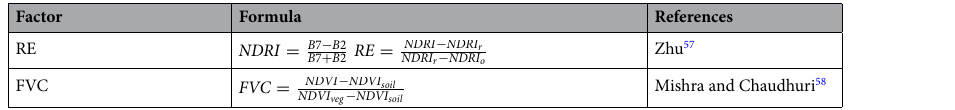
Table 6. FVC and RE were e xtracted using QGIS3.26.2 (https:// www. qgis. org/ en/ site/). NDRI normalized difference rock